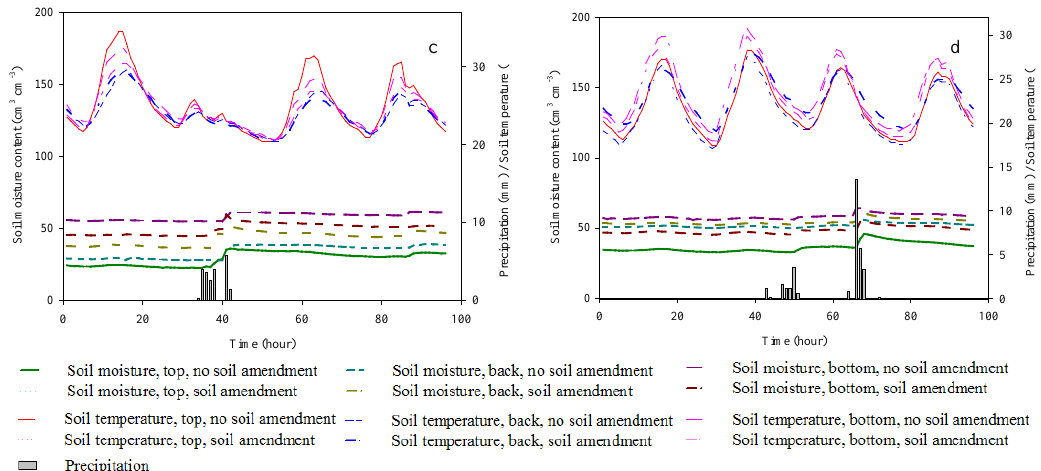
Figure 3. ( a – d ) represent the dynamics of soil temperature and soil moisture during the consecutive 96-h period from 27–30 May 2015, 14–17 May 2016, 24–27 June 2015 and 16–19 June 2016, respectively.